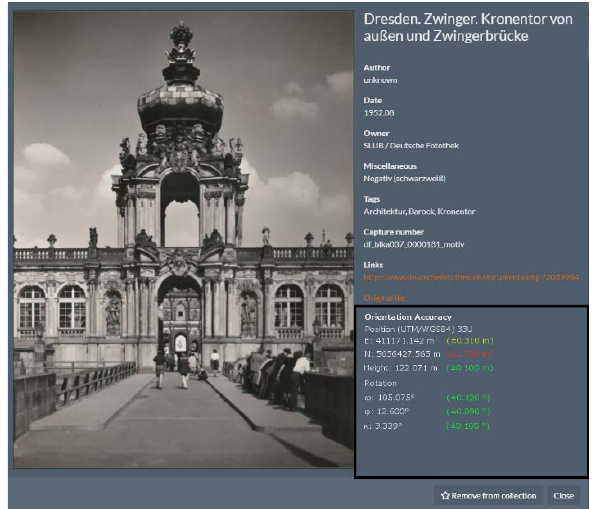
Figure 10. Data sheet of the depicted image showing additional accuracy values for the exterior orientation of the camera (mock-up)